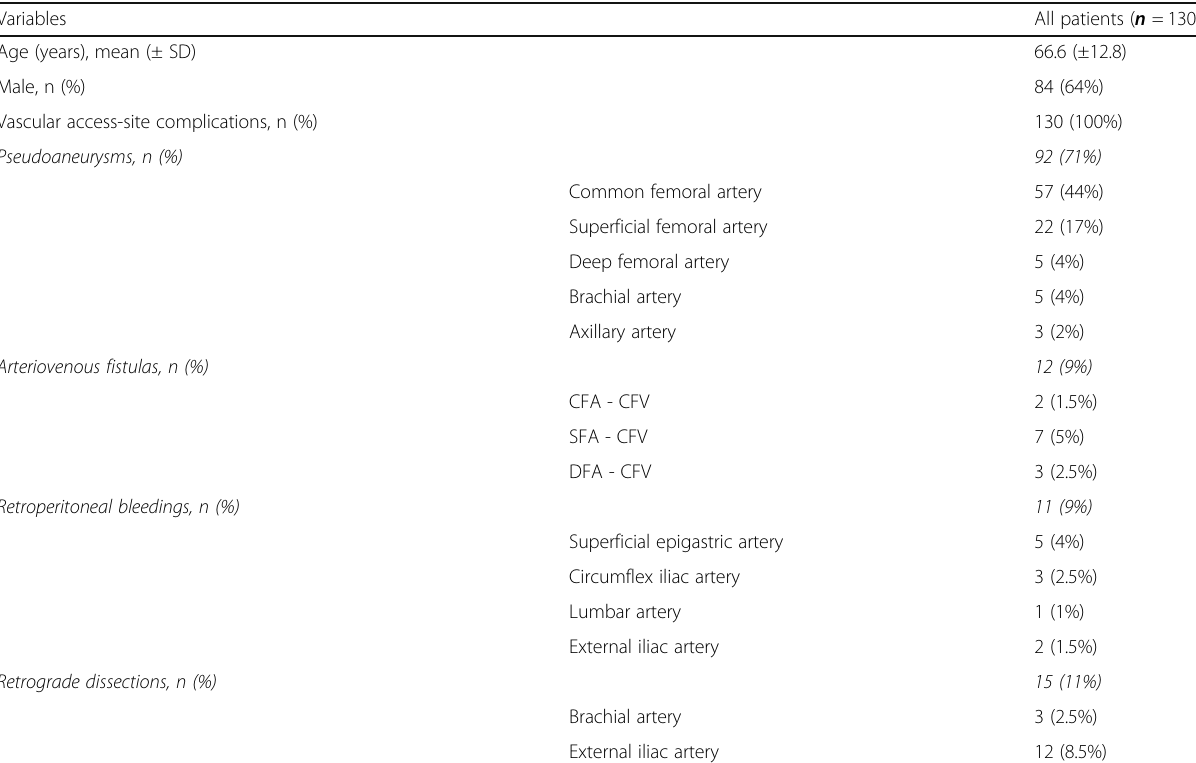
Table 1 Population data